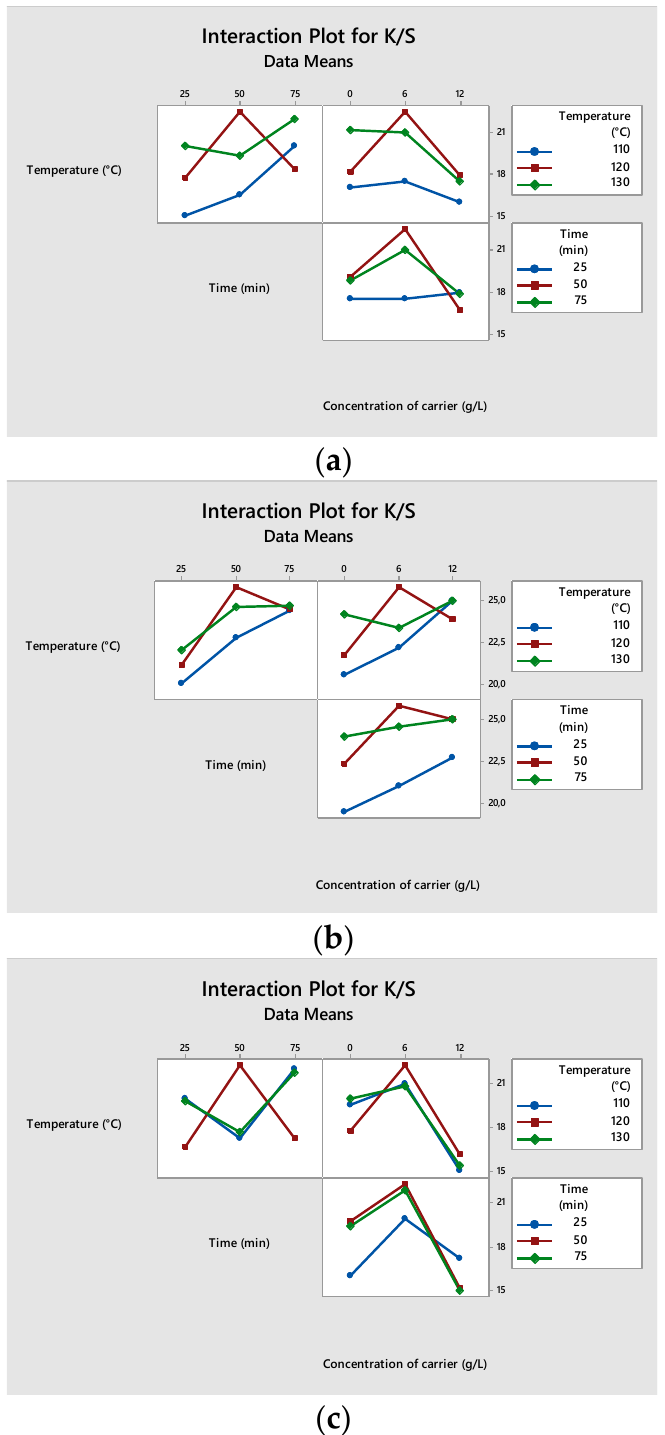
Figure 12. Interactions plots for color yield (K / S) of bicomponent filaments dyed with: ( a ) Dye #H; ( b ) Dye #M; ( c ) Dye #L.